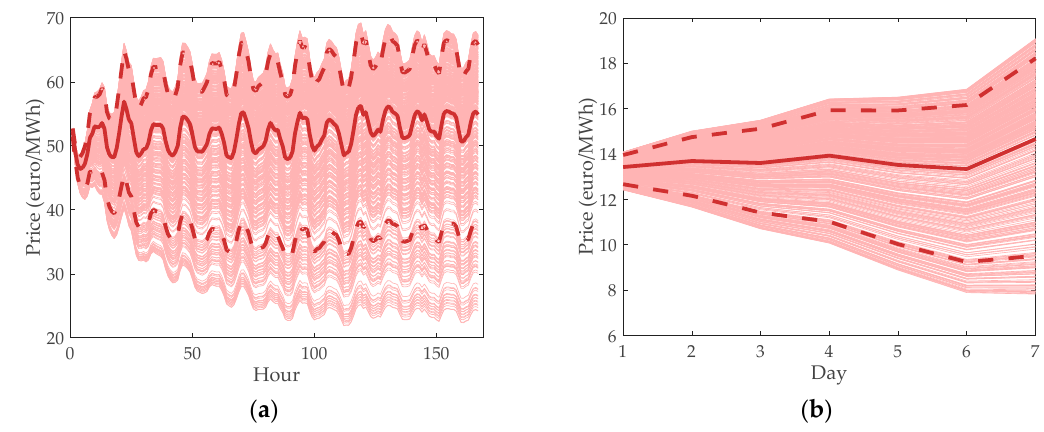
Figure 20. Out ‐ of ‐ sample scenarios. ( a ) Electricity price scenarios; ( b ) gas price scenarios. Figure 20. Out-of-sample scenarios. ( a ) Electricity price scenarios; ( b ) gas price